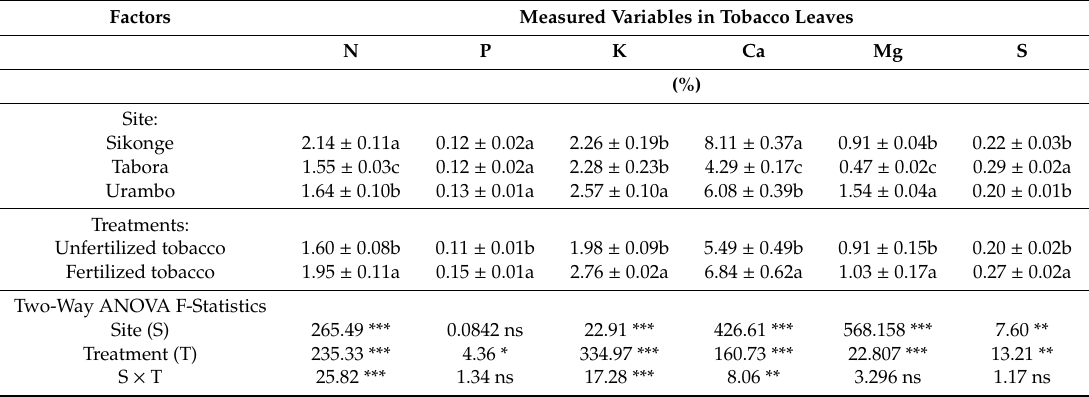
Table 5. Macronutrient concentration (%) in tobacco leaves harvested in fertilized and unfertilized soils. Factors